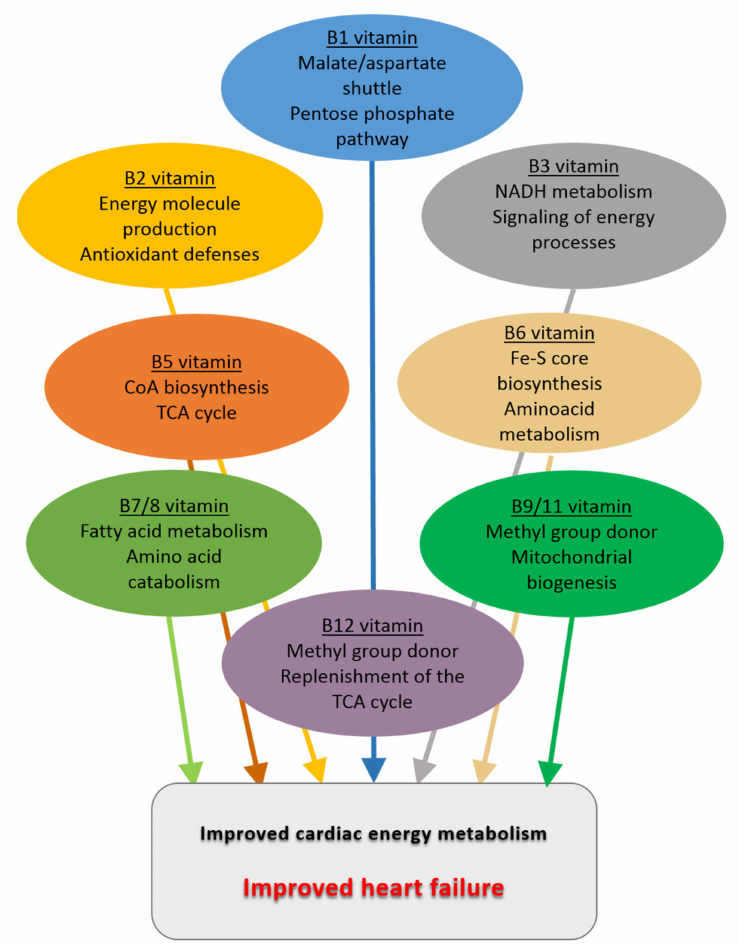
Figure 3. Main effects of B vitamins on energy metabolism and their potential benefits in heart